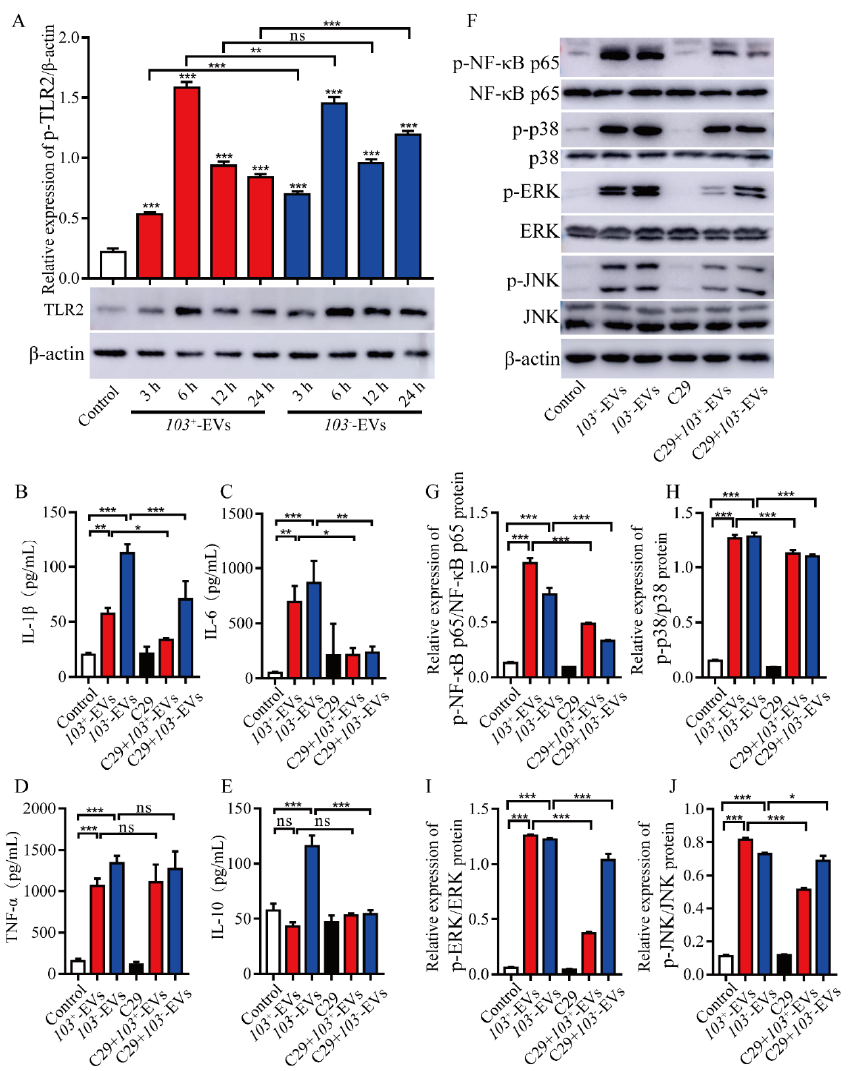
Figure 6. 103 + ‐ EVs and 103 − ‐ EVs induced cytokines secretion was regulated by TLR2 signaling pathway. ( A ) J774A.1 cells were co ‐ incubated with 103 + ‐ EVs or 103 − ‐ EVs at concentrations of 5 μ g/mL for 3 h, 6 h, 12 h, and 24 h, the protein of TLR2 was detected by western blotting. The results of western blotting were analyzed by gray scale. Inhibitors of TLR2 (C29, 100 μ M) was used to pretreat for 1 h before stimulation J774A.1 cells with 103 + ‐ EVs or 103 − ‐ EVs at concentrations of 5 μ g/mL for 24 h, and then detected the protein levels of ( B ) IL ‐ 1 β , ( C ) IL ‐ 6, ( D ) TNF ‐α , and ( E ) IL ‐ 10 in the culture supernatants by ELISA. ( F ) Inhibitors of TLR2 (C29, 100 μ M) was used to pretreat for 1 h before stimulation J774A.1 cells with 103 + ‐ EVs or 103 − ‐ EVs at concentrations of 5 μ g/mL for 15 min, and then detected the phosphorylation of NF ‐κ B p65, p38, ERK and JNK protein by western blotting. The results of western blotting were analyzed by gray scale. Relative gray value shows the ratio of ( G ) Phospho ‐ NF ‐κ B p65 (p ‐ NF ‐κ B p65) to total NF ‐κ B p65 protein, ( H ) Phospho ‐ p38 (p38) to total p38 protein, ( I ) Phospho ‐ ERK (p ‐ ERK) to total ERK protein, and ( J ) Phospho ‐ JNK (p ‐ JNK) to total JNK protein. The data were compared with the control cells. The comparisons between groups were performed by one ‐ way ANOVA followed by Tukey’s test. * p < 0.05, ** p < 0.01, *** p < 0.001, and ns, not significant.